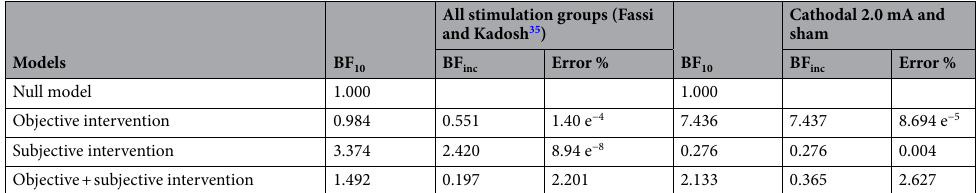
Table 2. Comparison of the summarised Bayesian ANOVA of objective intervention and subjective intervention findings from Fassi and Kadosh 35 and the present study evaluating cathodal 2.0 mA stimulation